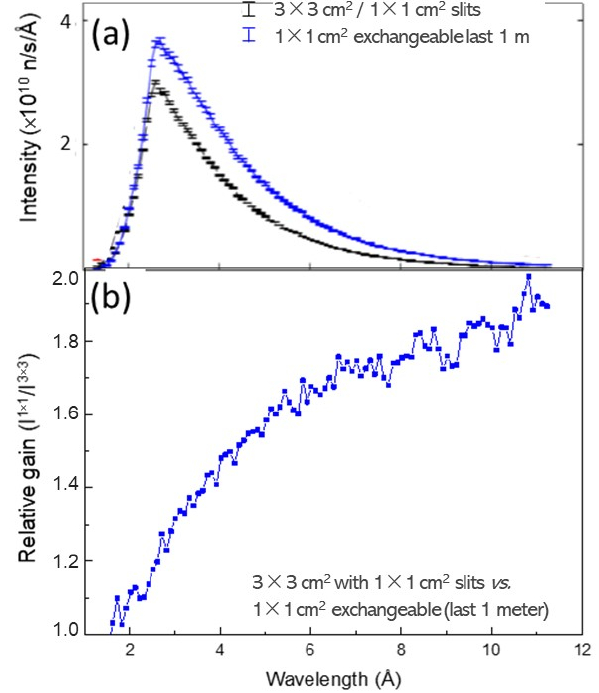
Figure 11. ( a ) Spectra corresponding to the 2 configurations (current focusing guide for 3 × 3 cm 2 samples, with slits opened by 1 × 1 cm 2 , and focusing nose for 1 × 1 cm 2 , with an exchangeable section in the last 1 m); ( b ) Intensity ratio between both spectra as a function of the neutron wavelength.